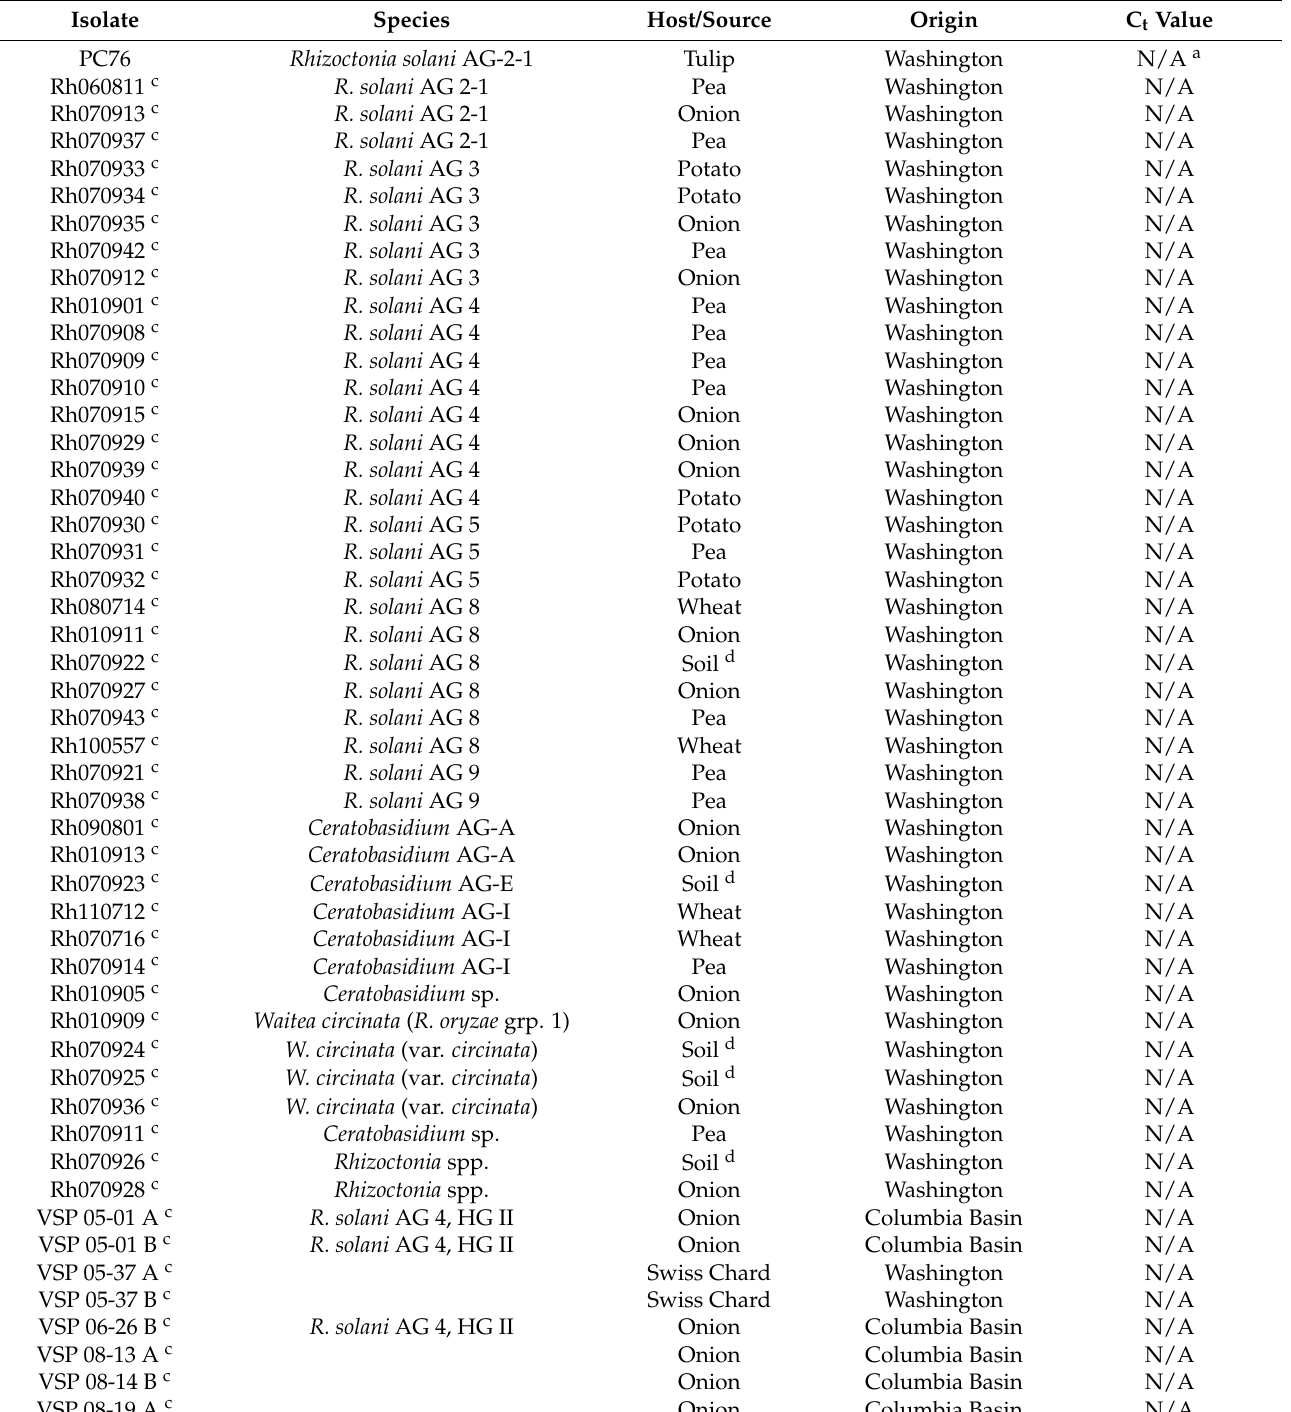
Table 1. Fungal isolates used to test species specificity of the TaqMan qPCR assay for Rhizoctonia tuliparum , and their resulting Rtul cycle threshold (C t )